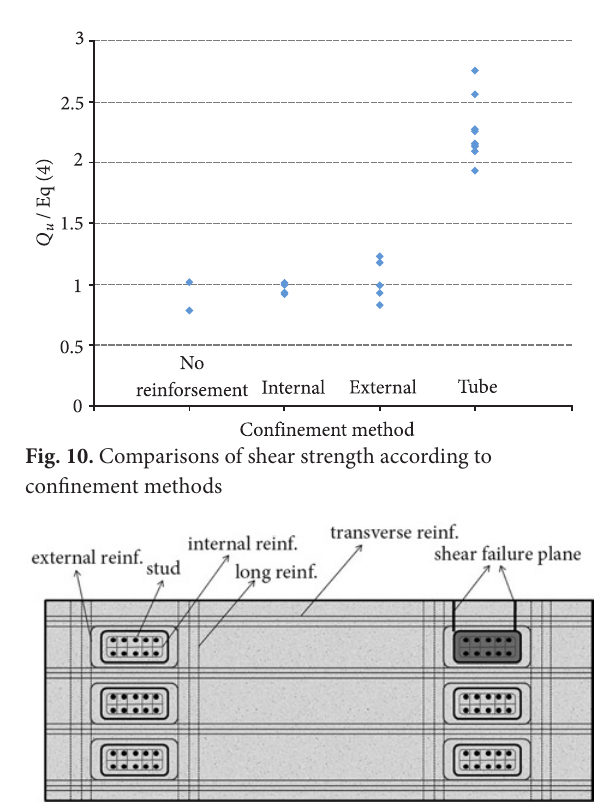
Fig. 9. Shear strength of group stud shear connection